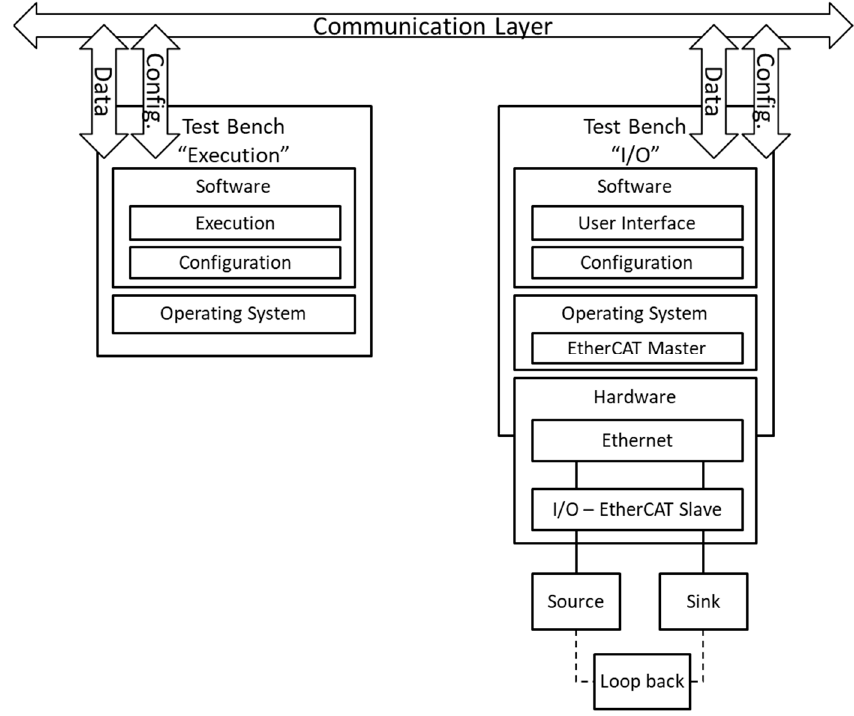
Figure 11. Test bench interconnection.